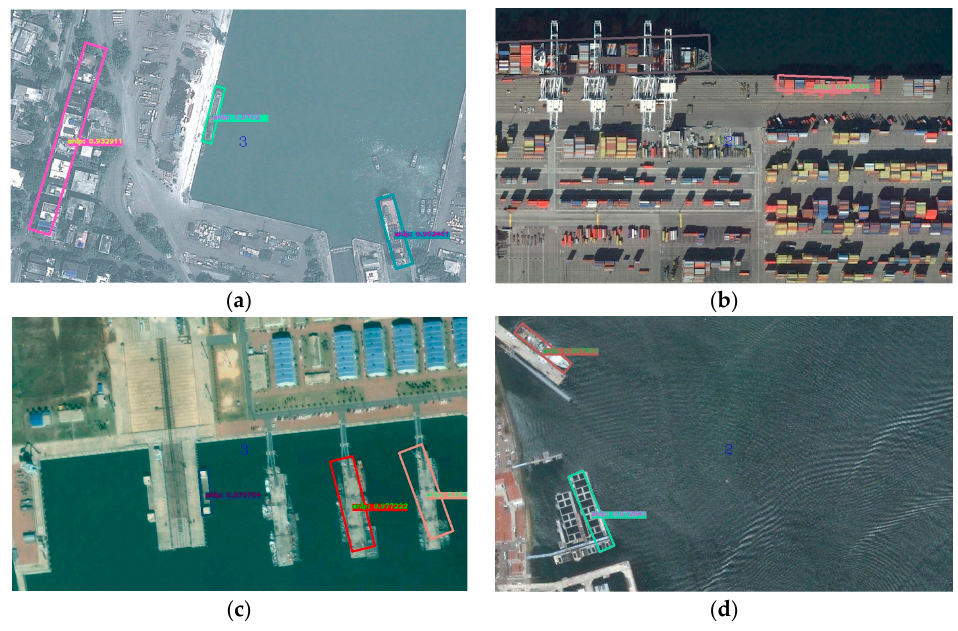
Figure 10. False alarms caused by different disturbances. ( a ) Roofs; ( b ) Container pile; ( c ) Dock; ( d ) Floating objects.